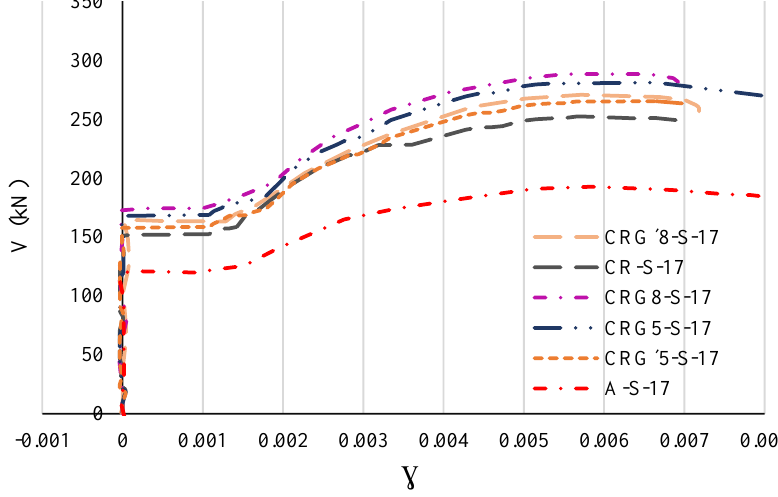
Figure 12. Shear force-shear deformation curves of reference and strengthened beams [37]. Table 9. Summary of shear capacity of